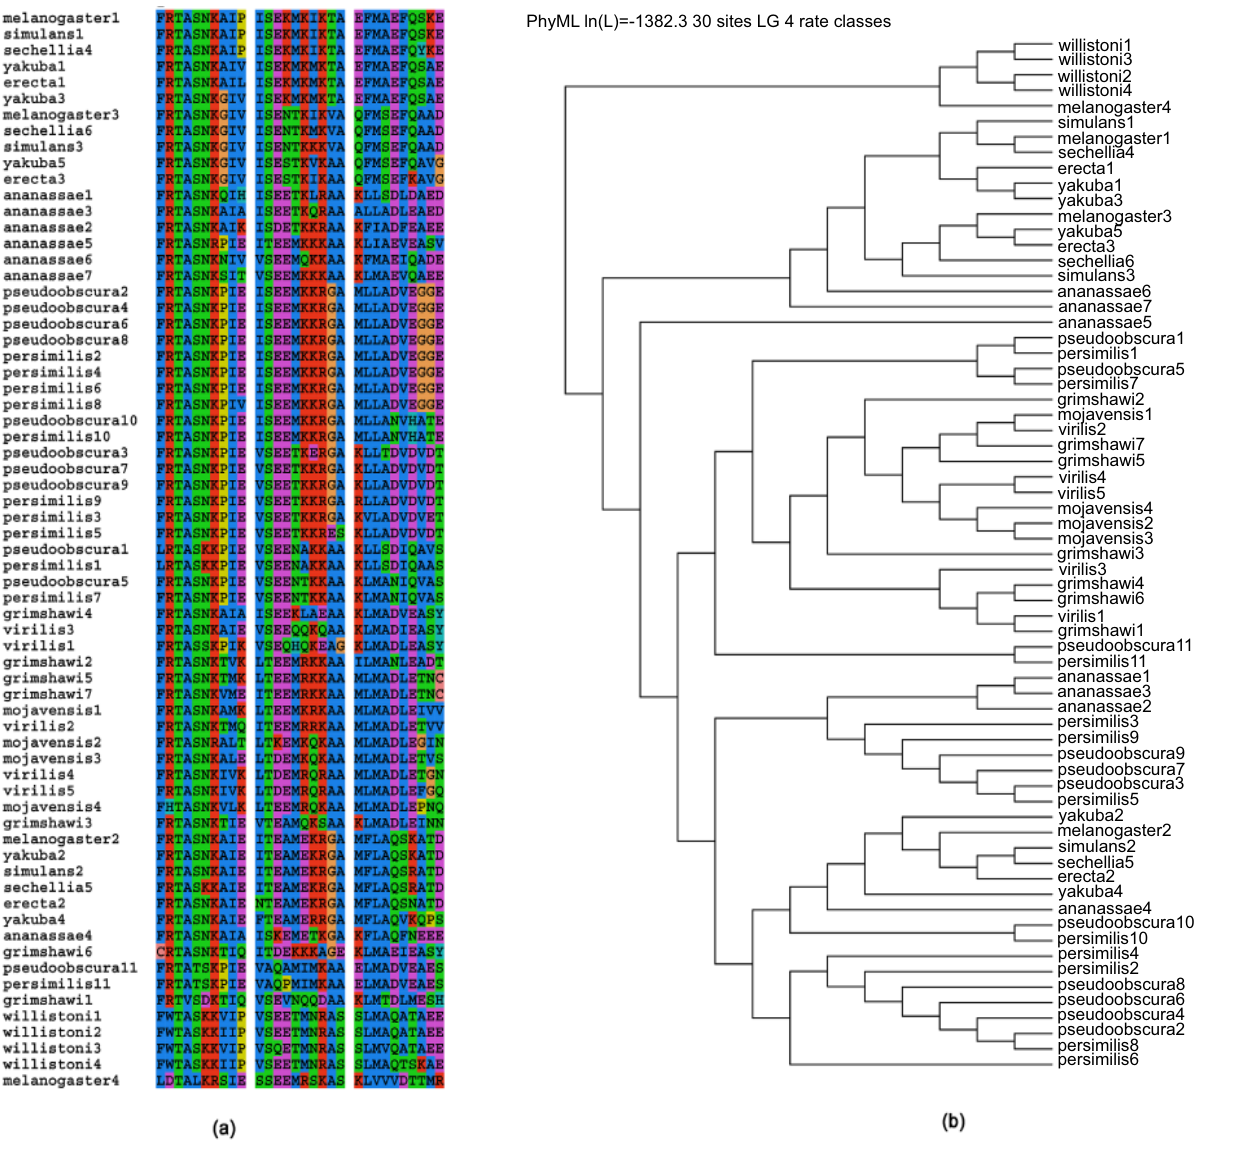
Figure S3. New BRC repeat identifed by FRAGAL in Drosophila melanogaster aligned using MAFFT. ( a ) The multiple alignment for this new sequence (634-664:LDTALKRSIESSEEMRSKASKLVVVDTTMR) (using ClustalW) marked as melanogaster4 and other sequences compared previously in 17 , using MAFFT for doing multiple sequence alignment. This putative sequence is more closely related to the sequences in D. willistoni than other members of the genus, as shown by the alignment done using ClustalW. ( b ) The phylogenetic tree corroborates the closer relation of the new BRC repeat to D. willistoni , similar to the ClustalW